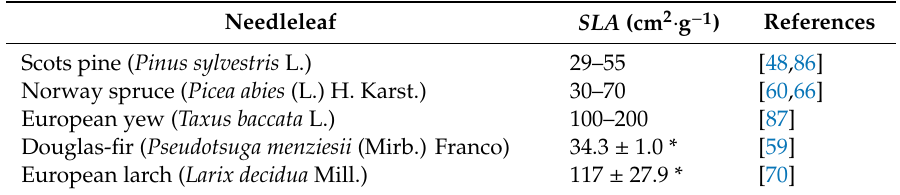
Table 4. SLA s of several needleleaf tree